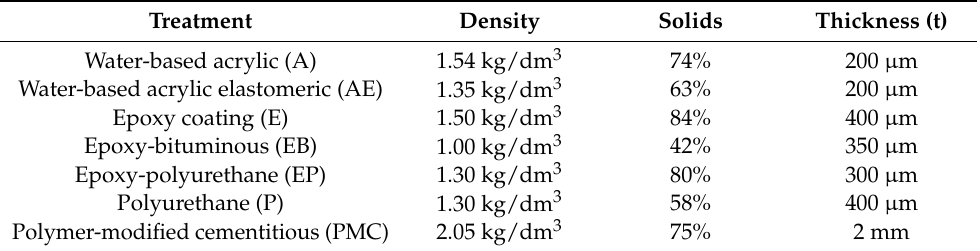
Table 2. Properties of surface treatments.